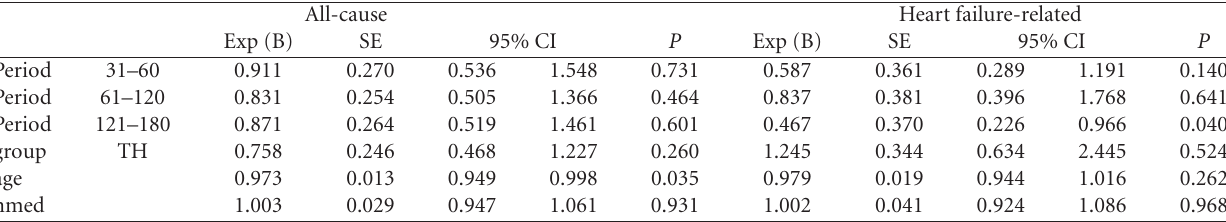
Table 7: Results from GEE model for hospital